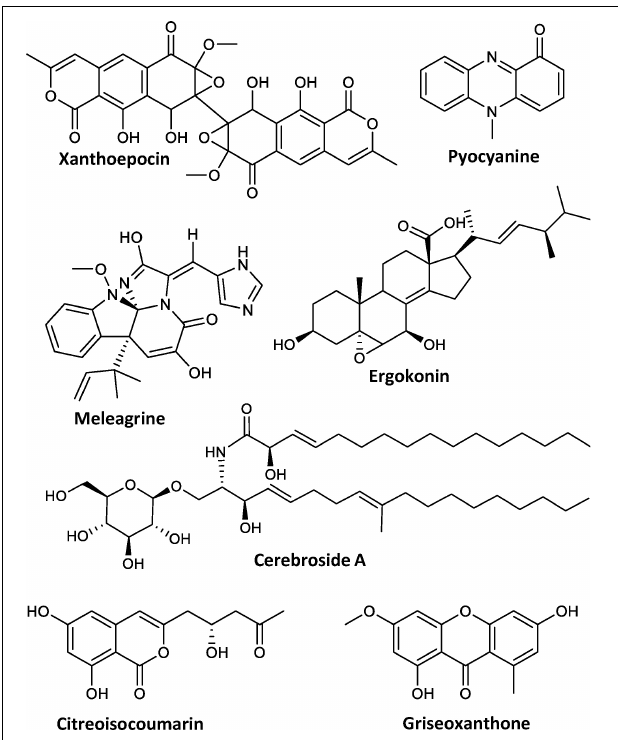
FIGURE 2 | Compounds produced by P. astrolabium based on the in-house database search.